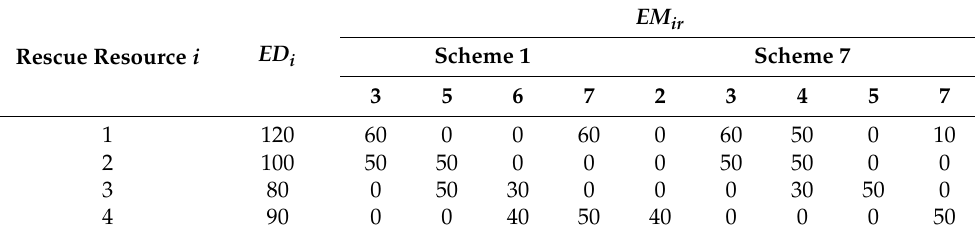
Figure 8. The distribution of obtained Pareto solutions. Table 12. The rescue resource scheduling of Scheme 1 and Scheme 7.